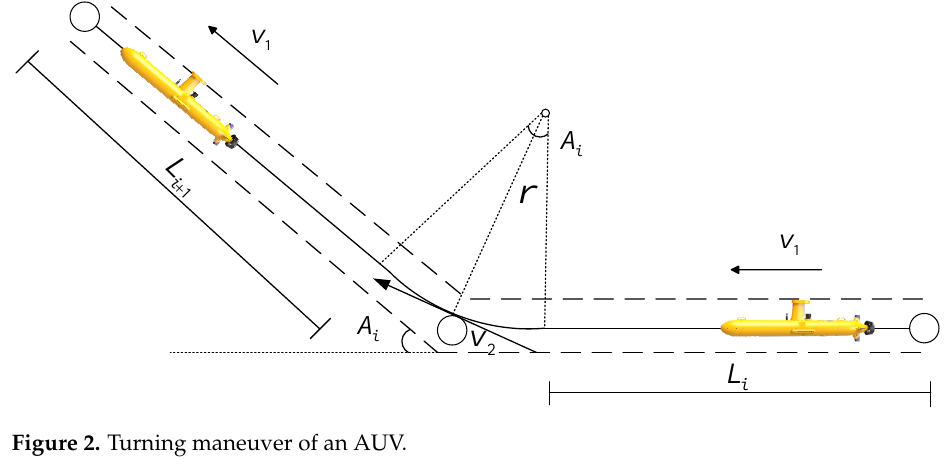
Figure 2. Turning maneuver of an